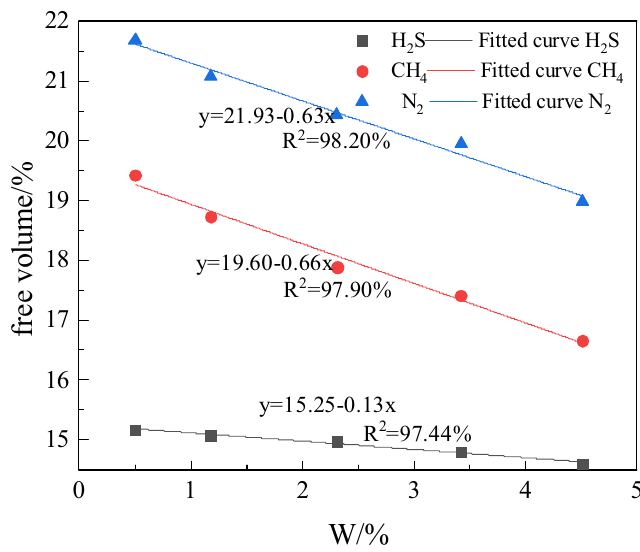
Figure 8. Free volume in coal of varying moisture content after adsorbing gas.